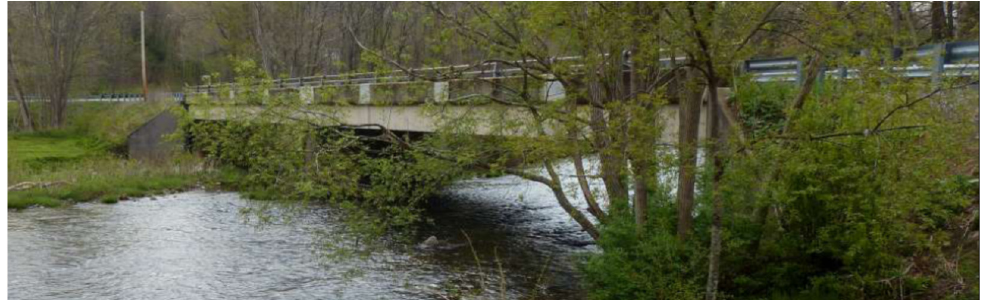
Figure 1. Upstream view of the 55-3014-0050-0509 bridge (Somerset bridge). Figure adapted from PennDOT bridge inspection